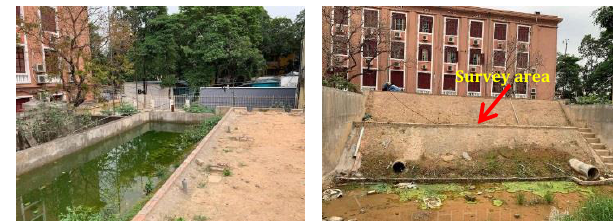
Figure 3: The artificial dam built at Thuyloi University for the SP measurement.